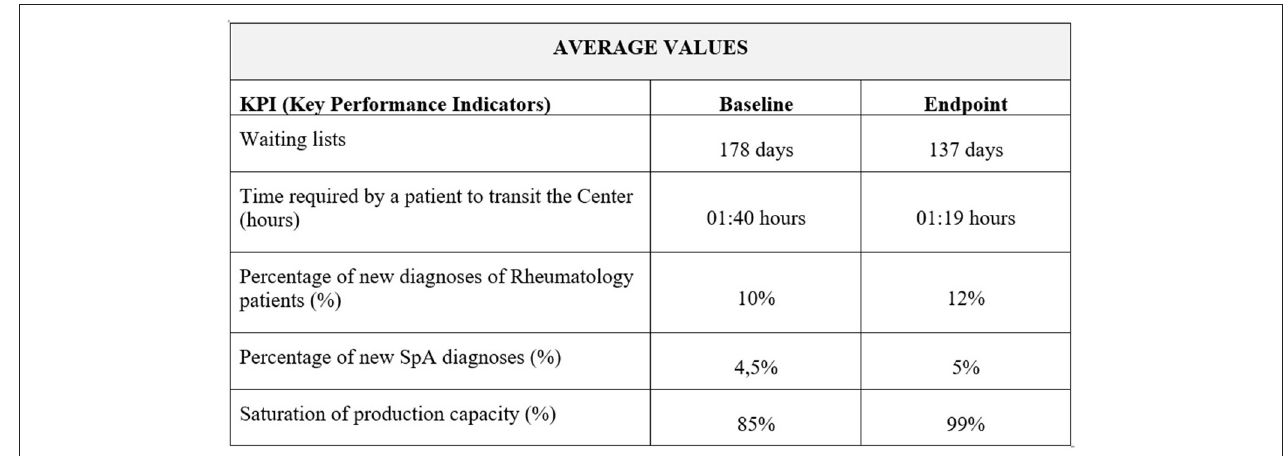
FIGURE 5 | Overview of results (total average